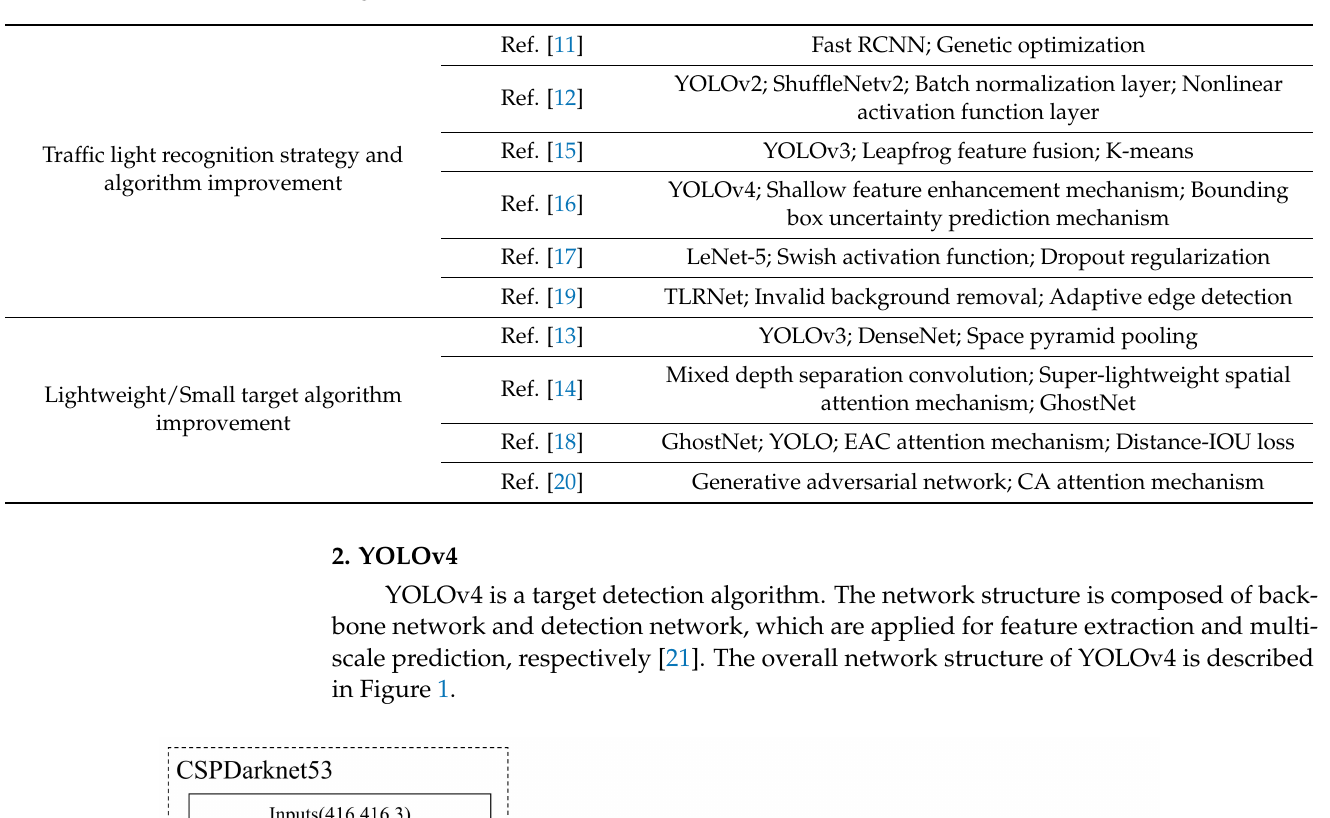
Table 1. Main reviewed works related to traffic light recognition strategy and lightweight/small target.